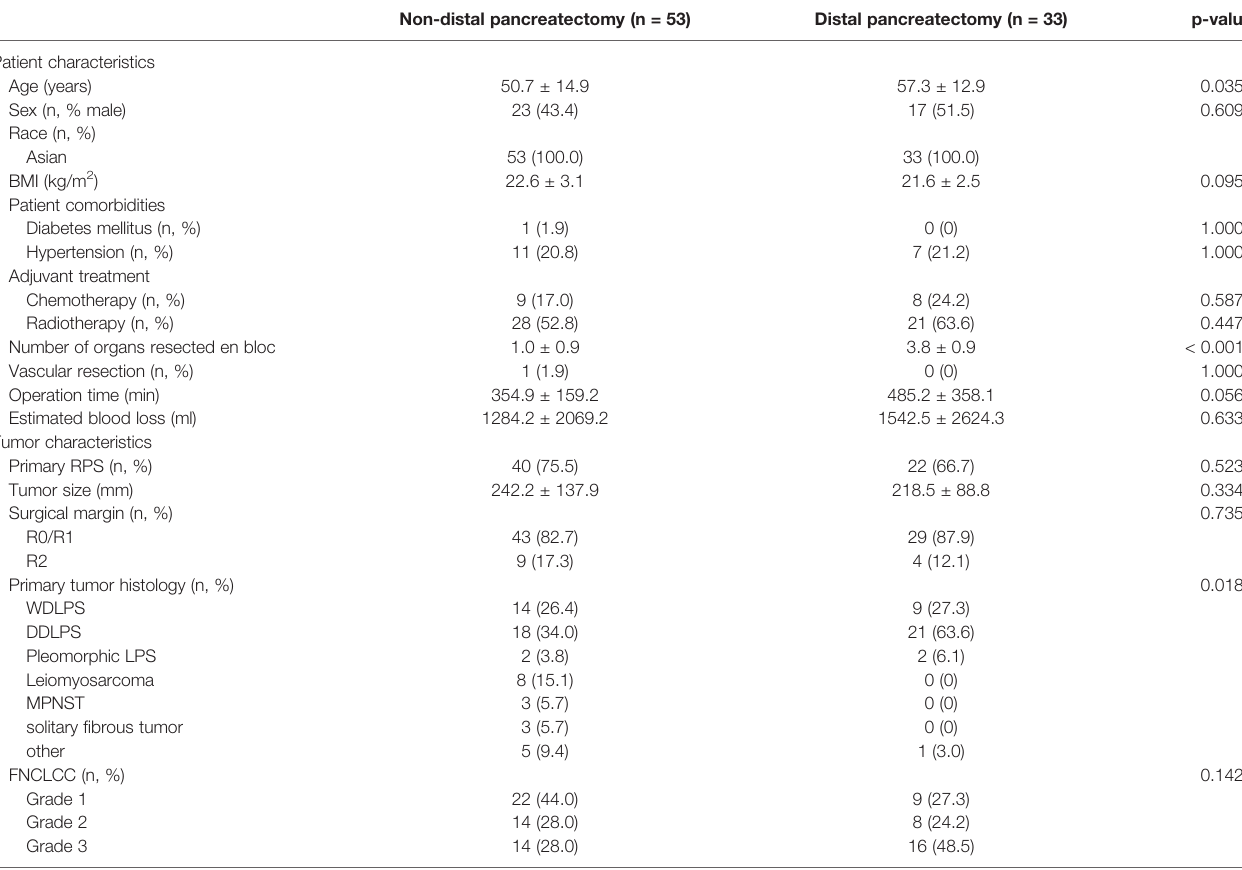
TABLE 1 | Clinicopathologic characteristics according to resection of the pancreas. Non-distal pancreatectomy (n = 53) Distal pancreatectomy (n =